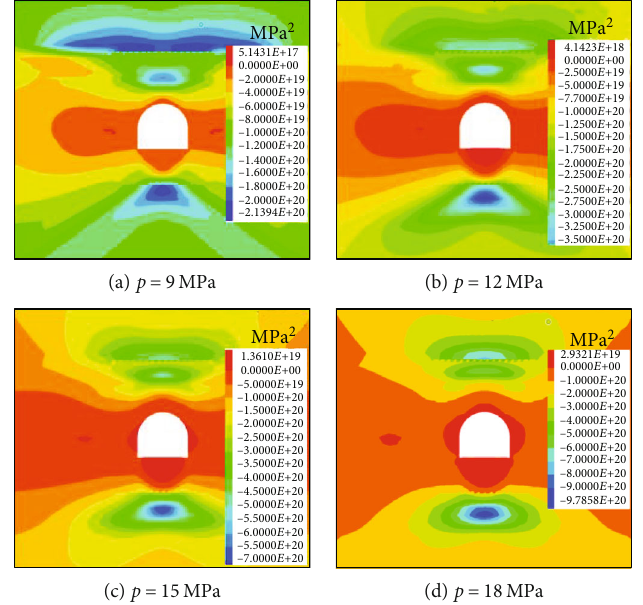
Figure 12: The J 3 distribution under various spherical stresses.